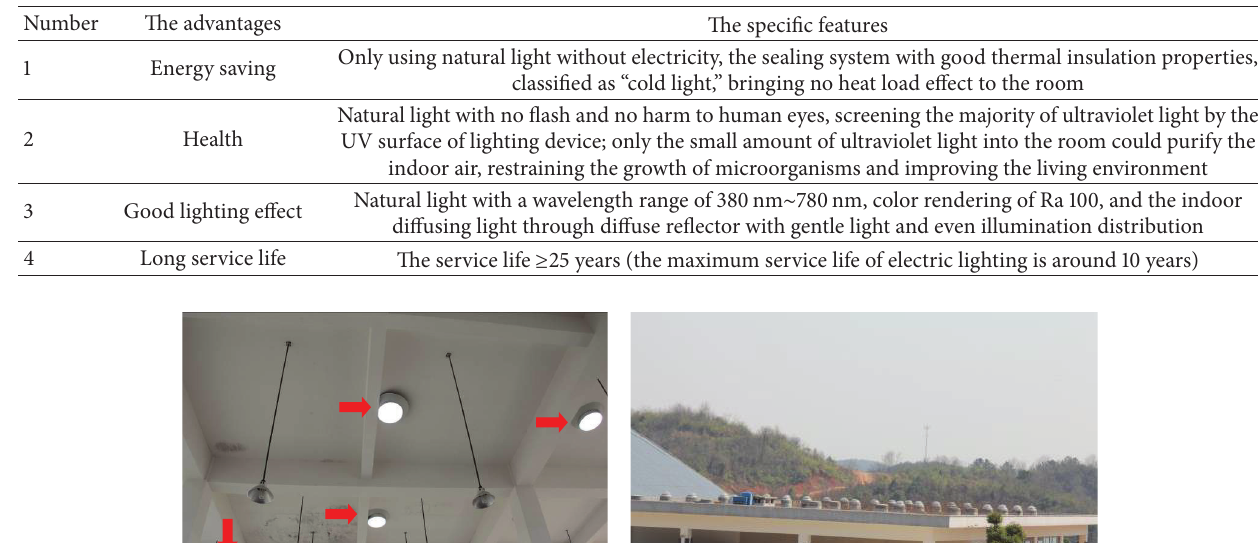
Table 1: The advantages of light guidance system.